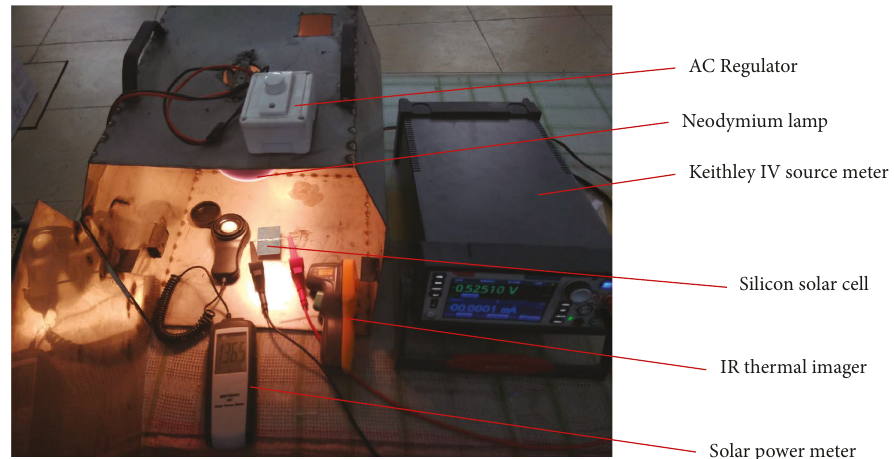
Figure 2: I-V measurement under a simulated light source.